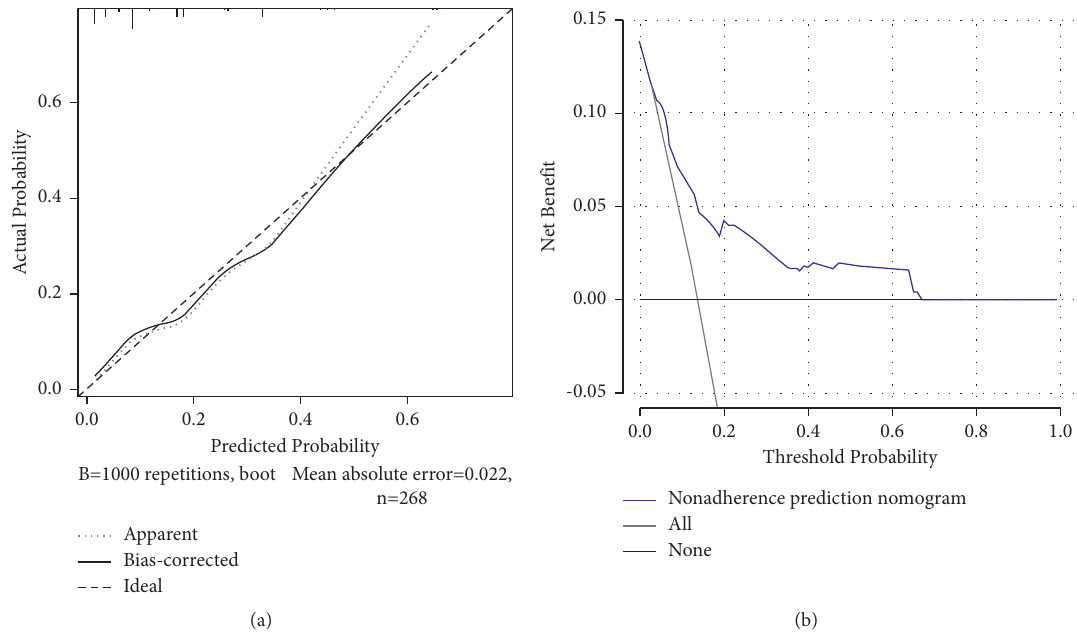
Figure 10: Calibration and decision curve of the nomogram for the probability of residual back pain after percutaneous vertebroplasty. (a) Calibration curve. (b) Decision